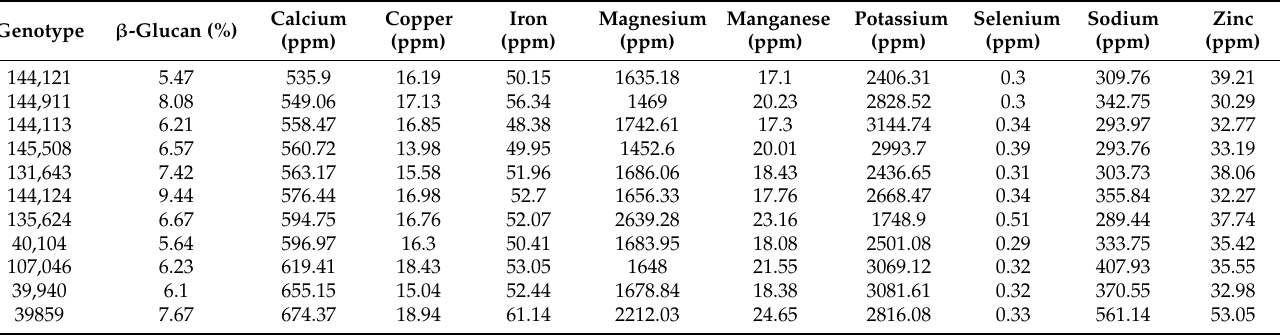
Table 9. Single plant accessions of Hordeum spontaneum with combined contents of β -glucan and microelements (Iron, Zinc, and Selenium) above the